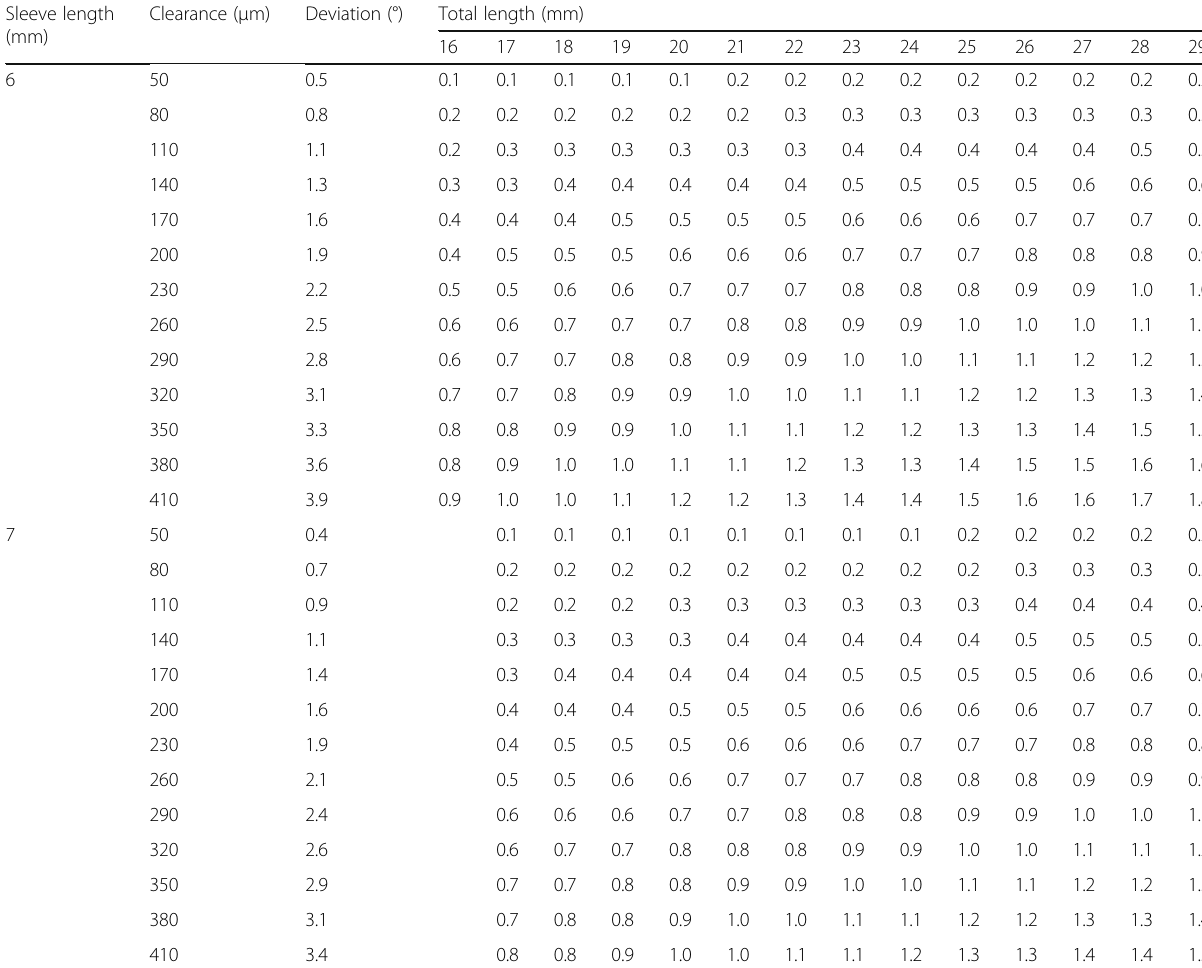
Table 3 Error at the apex (mm) and deviation of implant axis (degrees) for sleeve lengths 6 and 7 mm Sleeve length